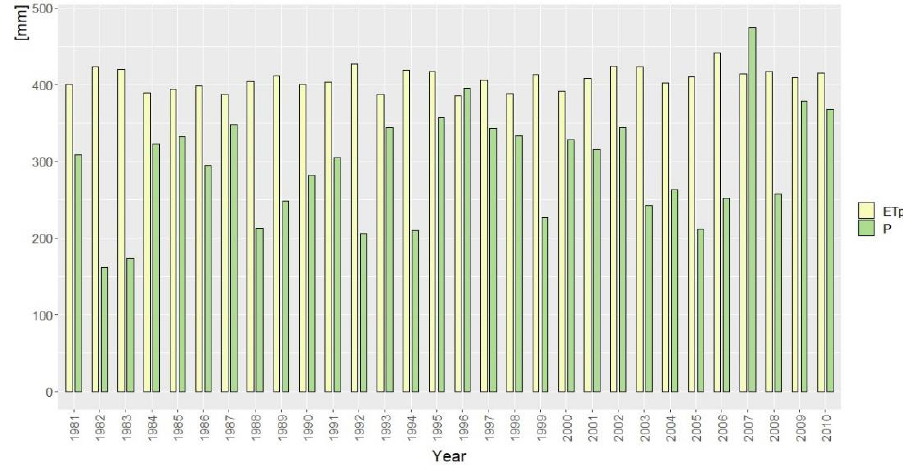
Figure 3. Precipitation ( P ) and water needs (ETp) in the growing season (third decade of May— October) in 1981–2010 in the West Pomeranian voivodeship (SD of P = 75.1, SD of ETp = 13.6). Table 2. Statistical characteristics of willow water needs (ETp) and precipitation during 1981–2010 for each province.